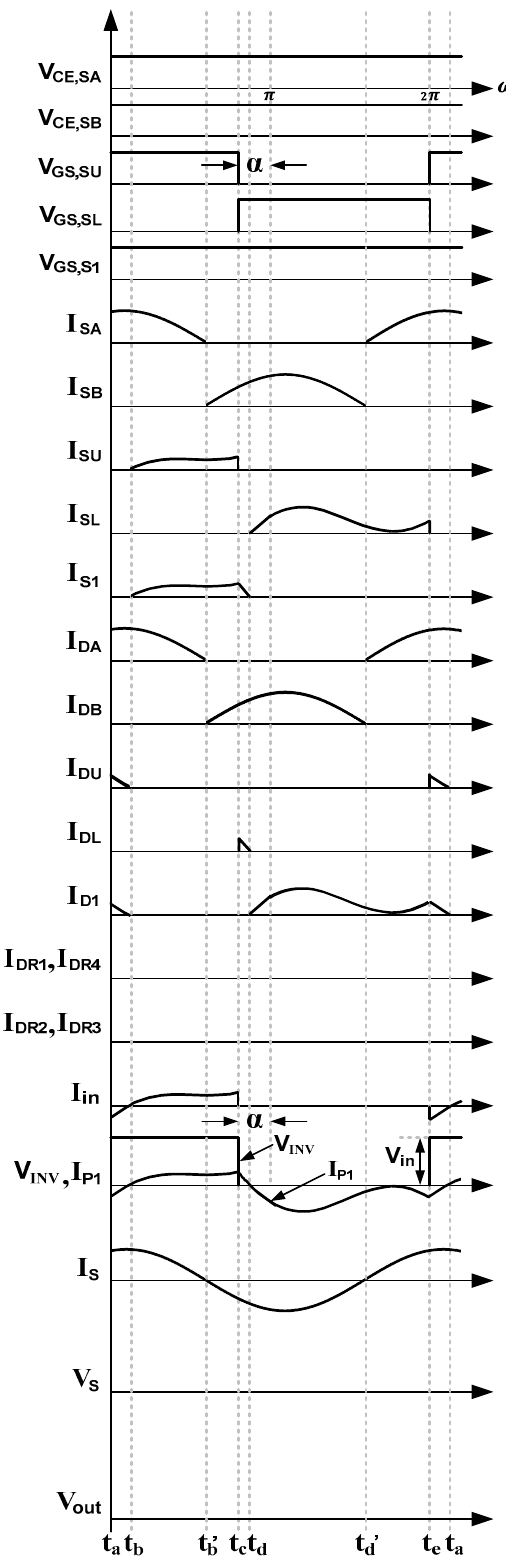
Figure 6. Timing diagram and theoretical waveforms of the detection mode.